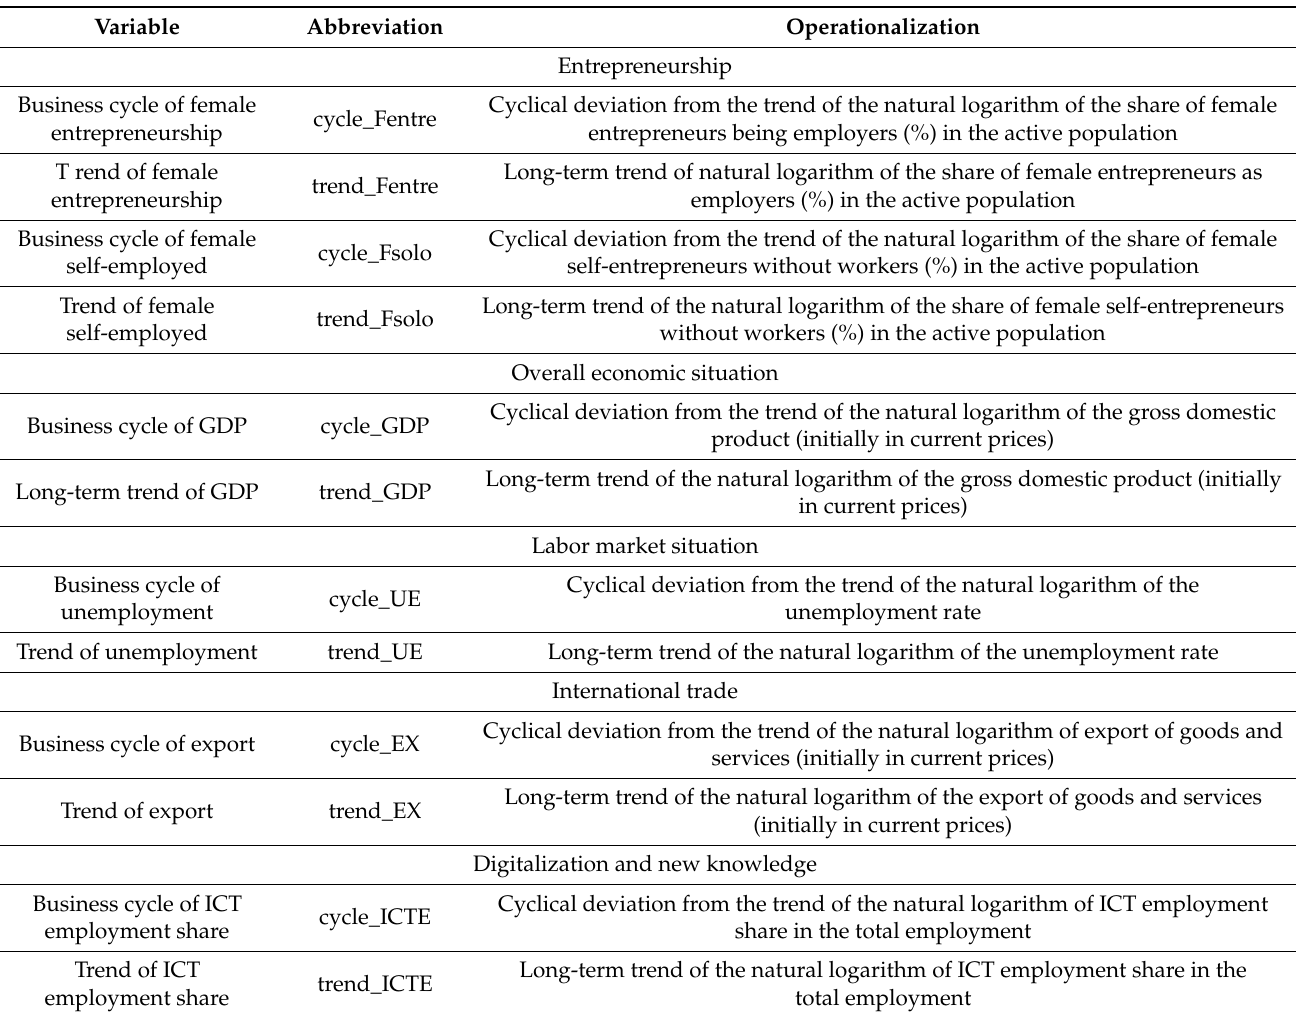
Table 1. List of